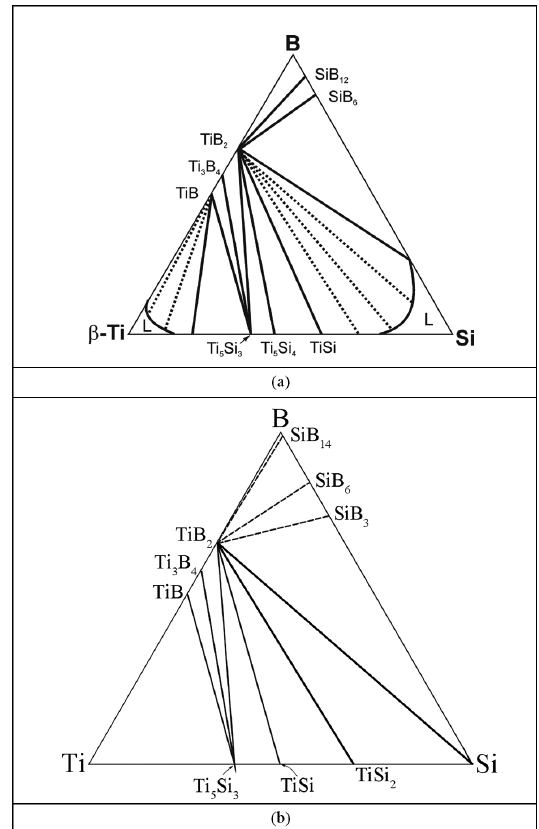
Figure 1. Calculated isothermal section of the Ti-Si-B system at (a) 1600 °C [1] ; (b) 727 °C [2] . Table 1. Nominal composition of the Ti-Si-B alloys used in this work. Alloy #